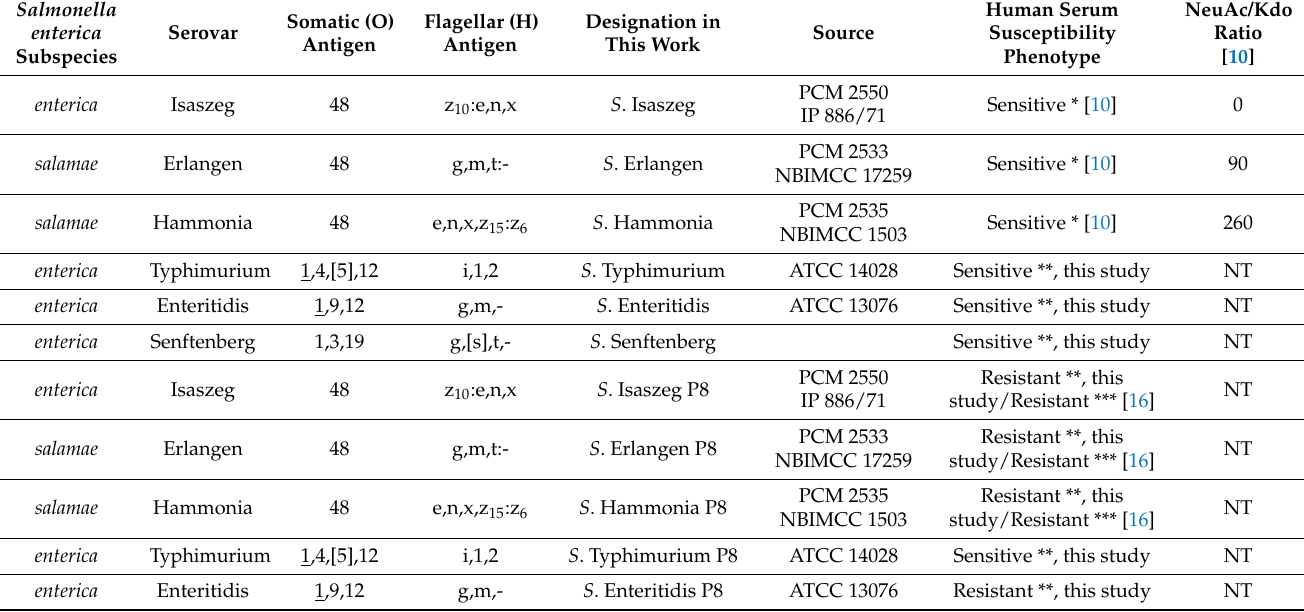
Table 6. The origin and antigenic characteristics of Salmonella enterica strains used in the study. Definitions of abbreviations: P8—strain passaged eight times in SPPP at 37 ◦ C; PCM—Polish Col- lection of Microorganisms, Hirszfeld Institute of Immunology and Experimental Therapy, Polish Academy of Sciences, Wroclaw, Poland; IP—Institute Pasteur, Paris, France; NBIMCC—National Bank of Industrial Microorganisms and Cell Cultures, Sofia, Bulgaria; ATCC—American Type Culture Collection; * sensitive to 75% normal human serum (NHS) at 37 ◦ C obtained from five volunteers who had not received any antimicrobial drug treatment for six months [10]; ** sensitive or resistant to 50% human serum from platelet-poor plasma (SPPP), sterile-filtered, mycoplasma and virus tested (Sigma-Aldrich, Poznan, Poland) at 37 ◦ C (this study); *** resistant to 50% normal human serum (NHS) at 37 ◦ C obtained from the Regional Center of Transfusion Medicine and Blood Bank, Wroclaw, Poland (120 donors) and approved by the authors’ institutional review board [16]; NeuAc/Kdo—the ratio of N -acetylneuraminic acid (NeuAc) to 3-deoxy-D-manno-2-octulosonic acid (Kdo) analyzed with GLC-MS; NT—not